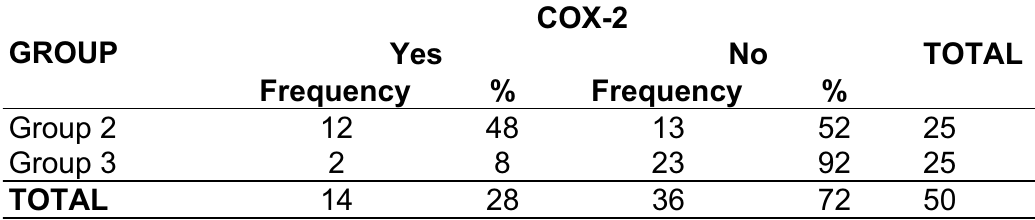
TABLE 2 – Analysis of the association between groups 2 and 3 in relation to COX-2 expression